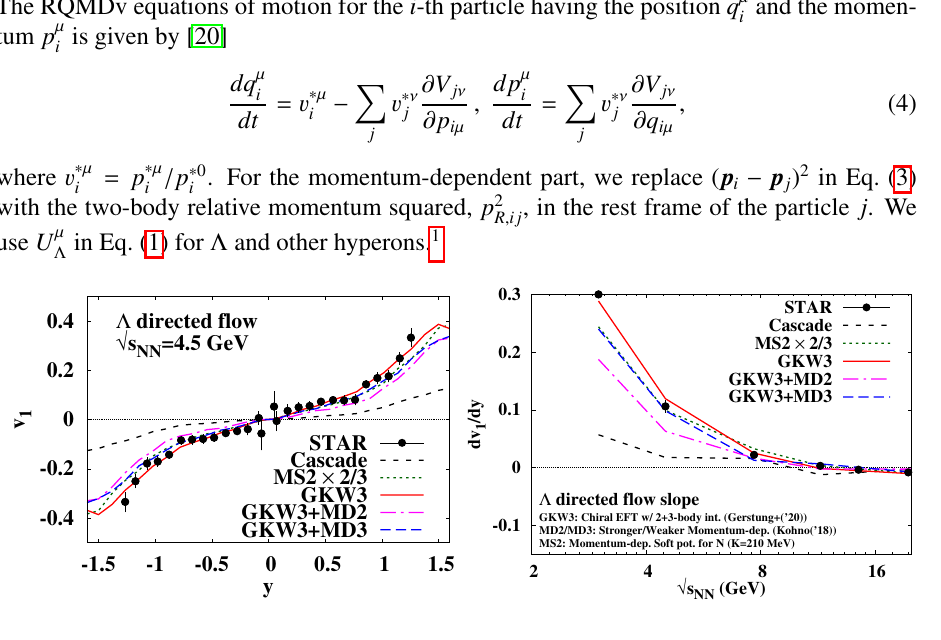
Figure 2. Left: Calculated directed flow of Λ in mid-central Au + Au collisions at Right: The directed flow slope of Λ . Data are taken from Ref.